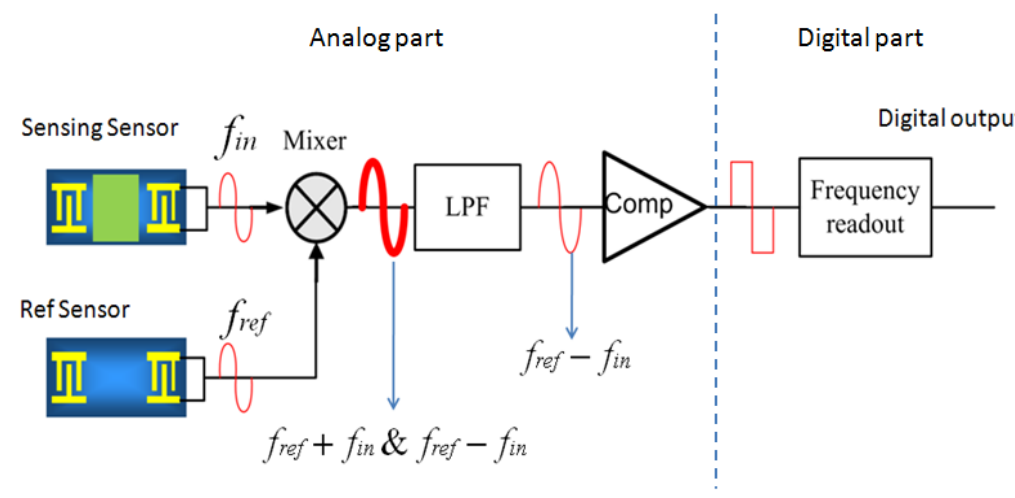
Figure 5. Block diagram of the mixed-signal interface chip.